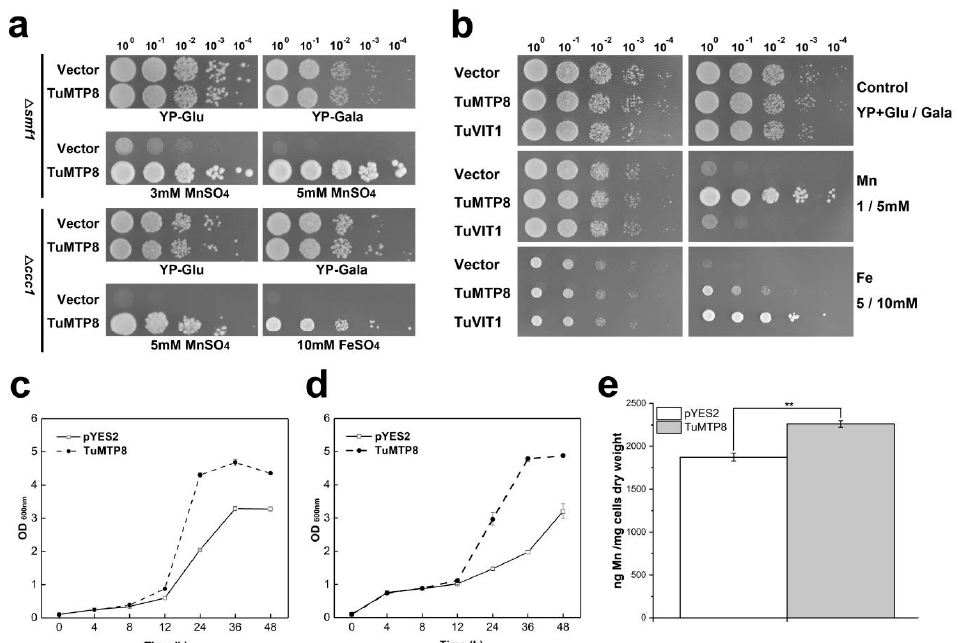
TuMTP8 -overexpressing Arabidopsis lines relative to WT (Figure 5a,d; p < 0.01). In addition, the shoots of the over-expressing lines grew well, whereas those of WT showed obvious chlorosis and impaired growth (Figure 5a–c). The fresh weight of the entire seedling was greater in the over-expressing lines than in the WT under 1 mM MnSO 4 treatment (Figure 5e; p < 0.01) and 180 µ M Fe treatment (Figure 5e; p < 0.05). No differences in growth were observed between the over-expressing lines and WT when the plants were grown with other metals (data not shown). Upon exposure to Mn, over-expressing lines accumulated less reactive oxygen species (ROS) than WT, as determined by both DAB and NBT staining (Figure S2). Thus, the over-expressing lines showed enhanced tolerance to excess Mn.